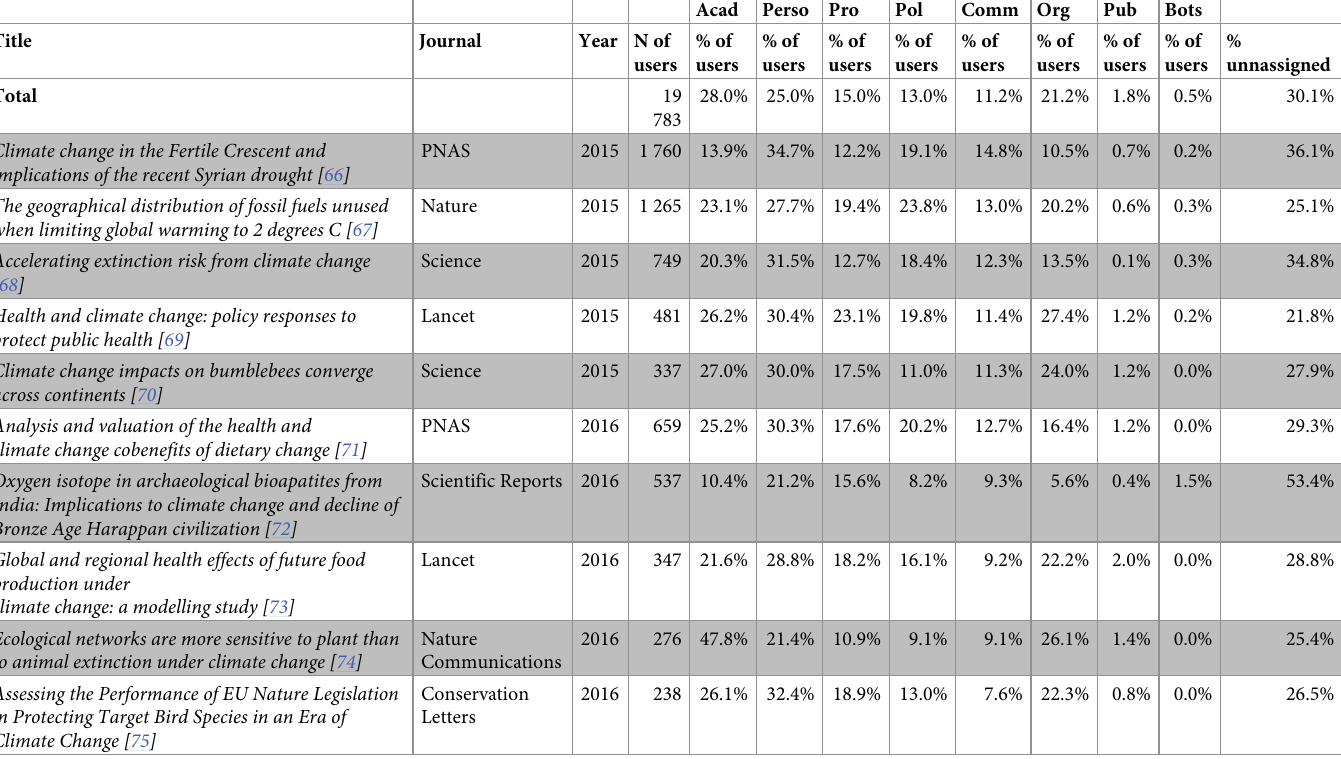
Table 4. General results of the word detection